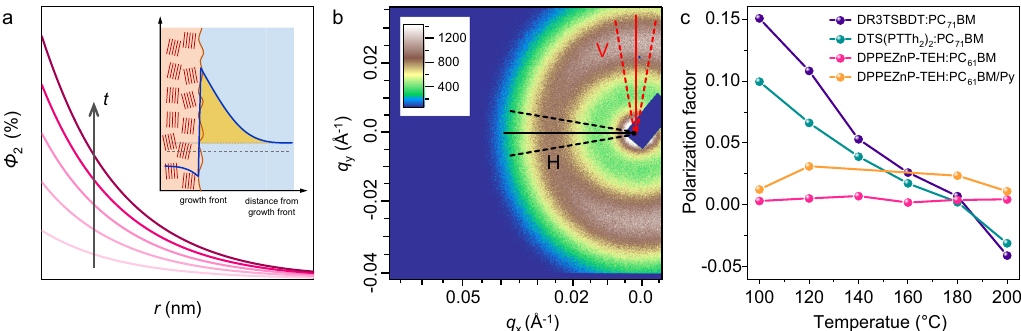
Fig. 7 Bulk heterojunction interfacial properties. a Schematic PCBM concentration ( Φ 2 ) pro fi les as a function of distance from the growth front ( r ) and time ( t ). Inset is composition pro fi les at growth front of Region II. b Resonant soft X-ray scattering (RSoXS) 2D image of DR3TSBDT:PC 71 BM under 100 °C annealing. The area between dashed line around horizontal direction (H) and vertical direction (V) indicated by solid black and red line, respectively are used to calculate polarization factor. c Polarization factor change with different annealing